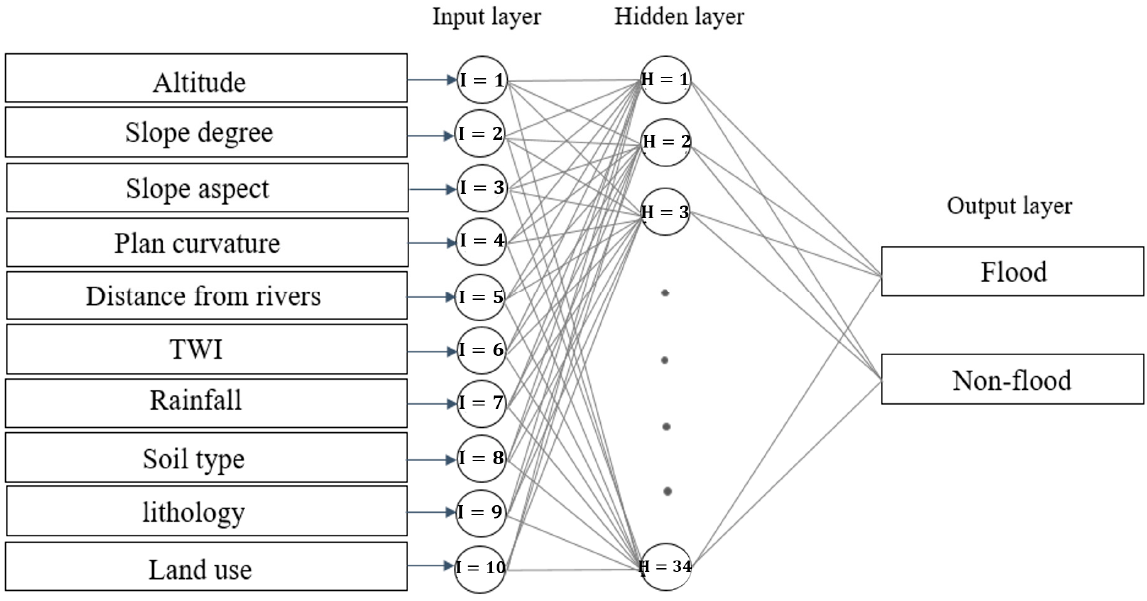
Figure 6. The MLP-FR model architecture.